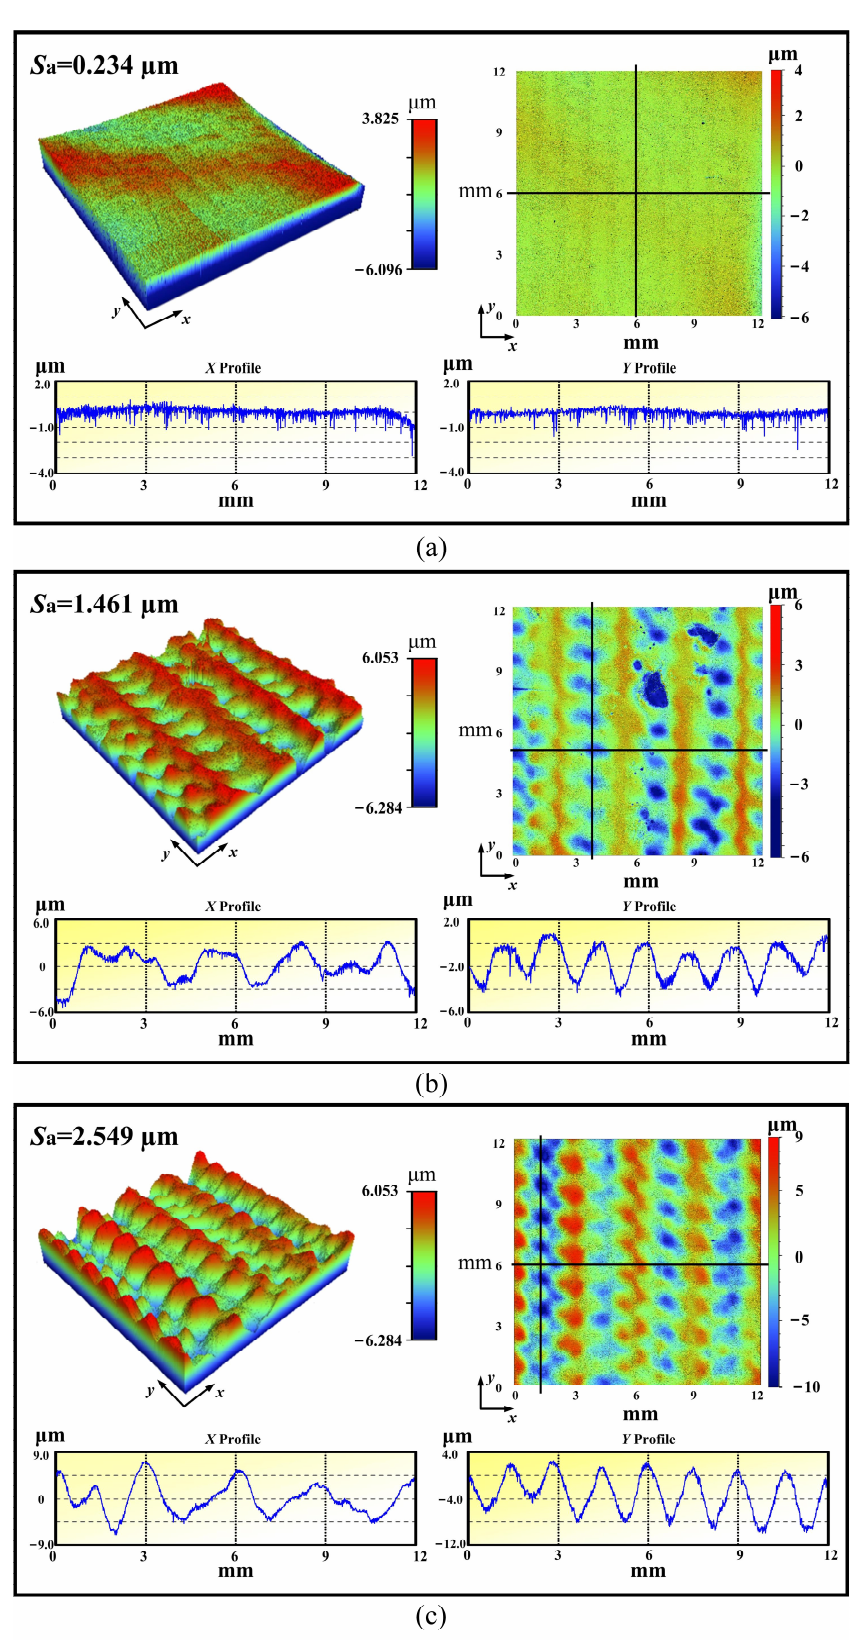
Figure 2. Surface topographies for Ti-13Nb-13Zr experimental coupons: ( a ) untreated; ( b ) 6J-1time; and ( c ) 6J-3times.